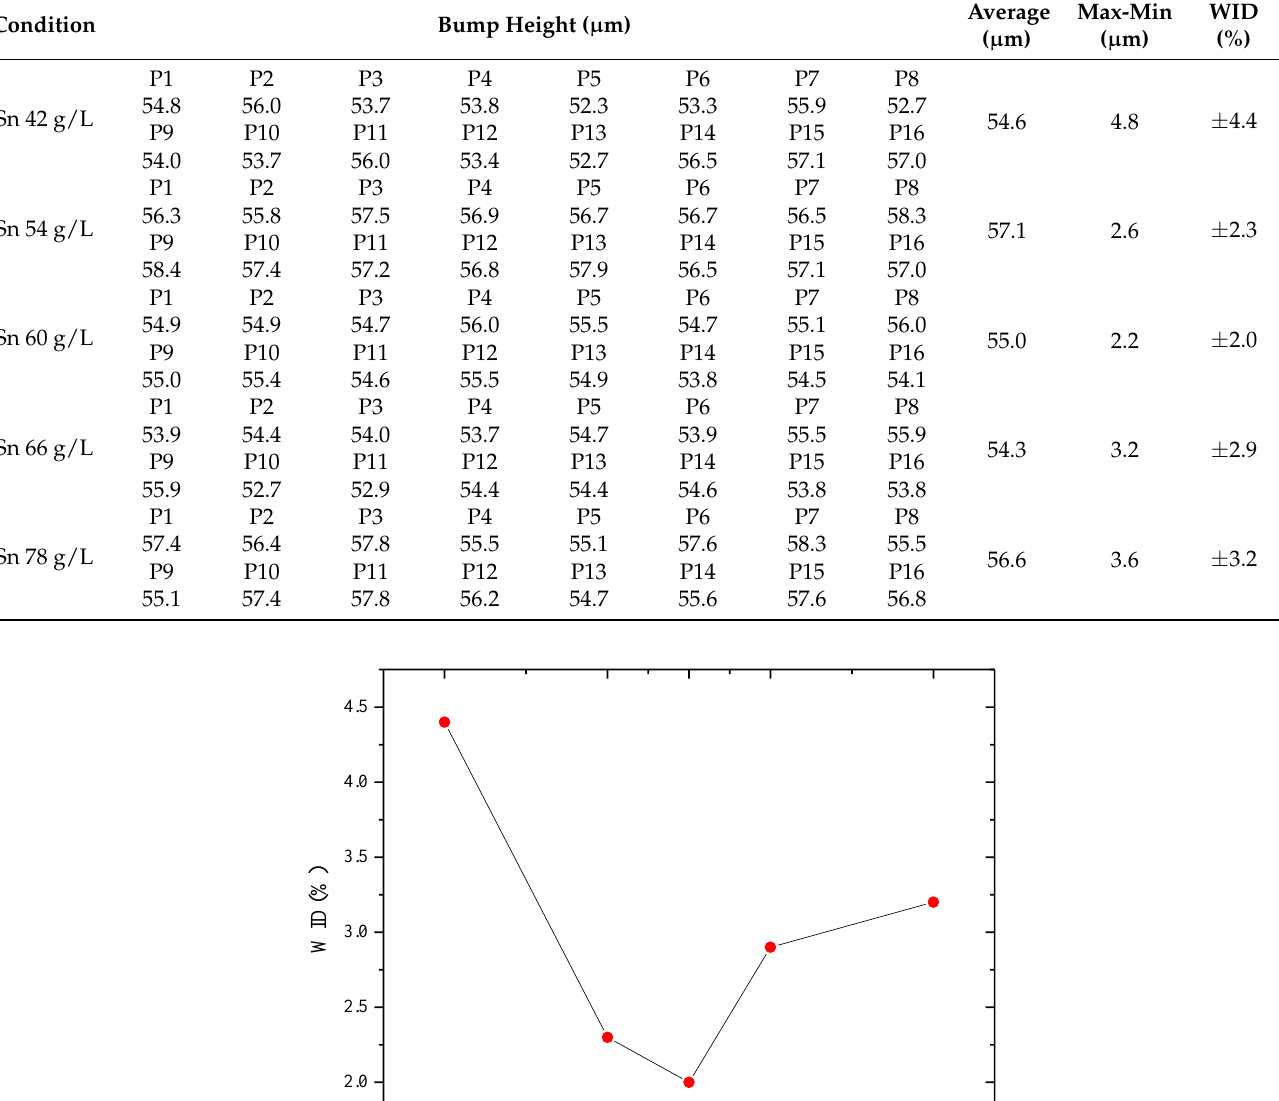
Table 2. Condition and measurement of Sn concentration.